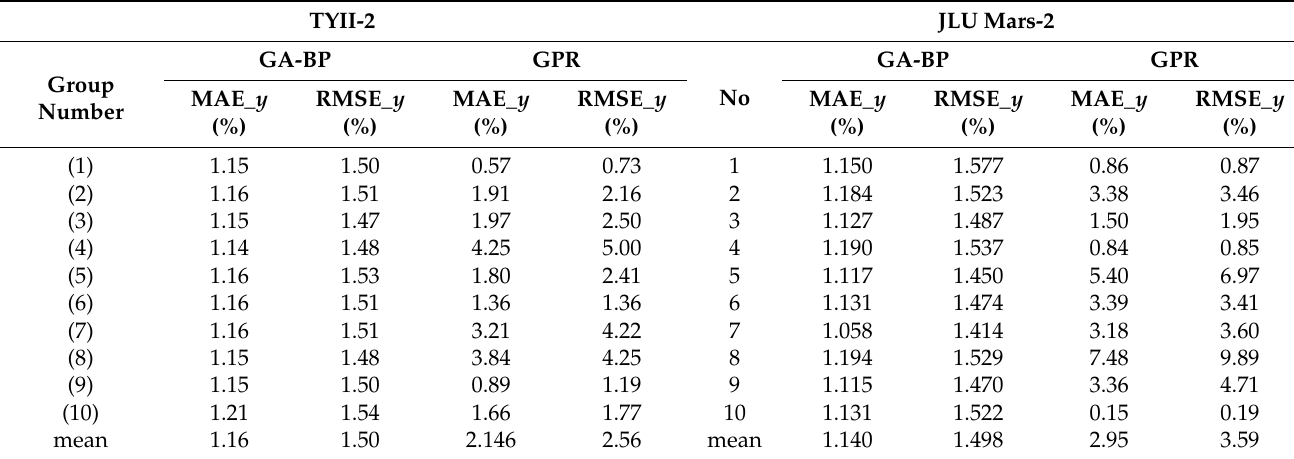
Table 4. Estimation results of GPR on TYII-2 and JLU Mars-2 (slip_ y ). TYII-2 JLU